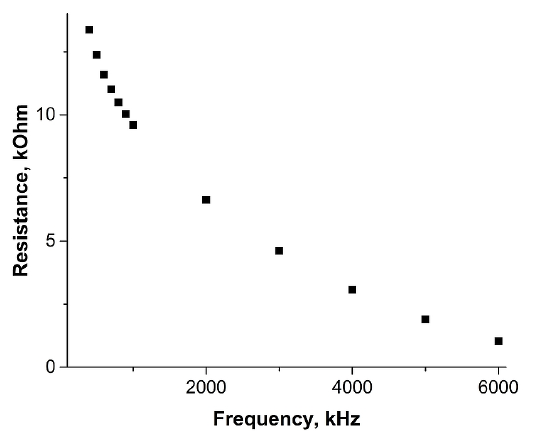
Figure 4. Calculated Δ G of the proposed polycondensation reactions in dichloromethane and in vacuum.